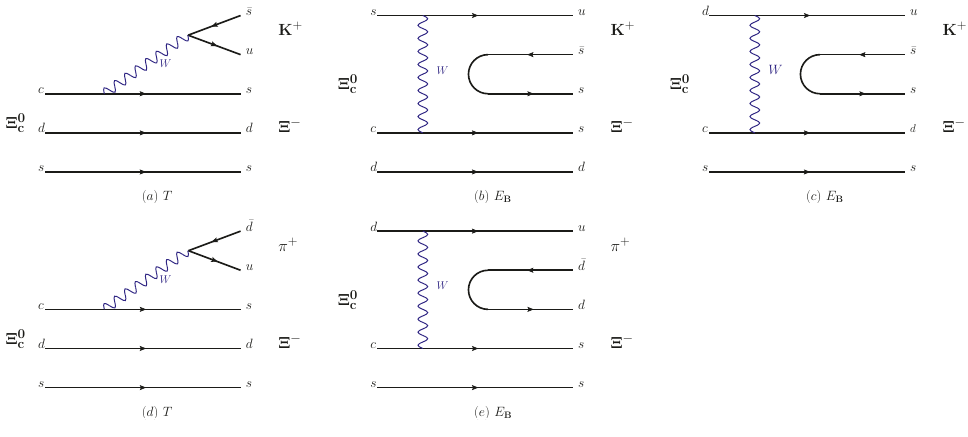
Figure 2 . Decay processes (a,b,c) and (d,e) for (cid:4) 0